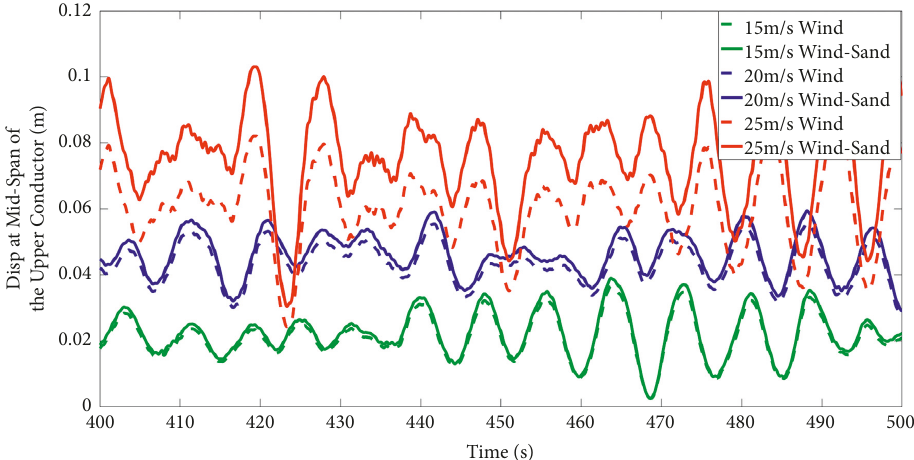
Figure 8: Displacement at the mid-span of the upper conductor.